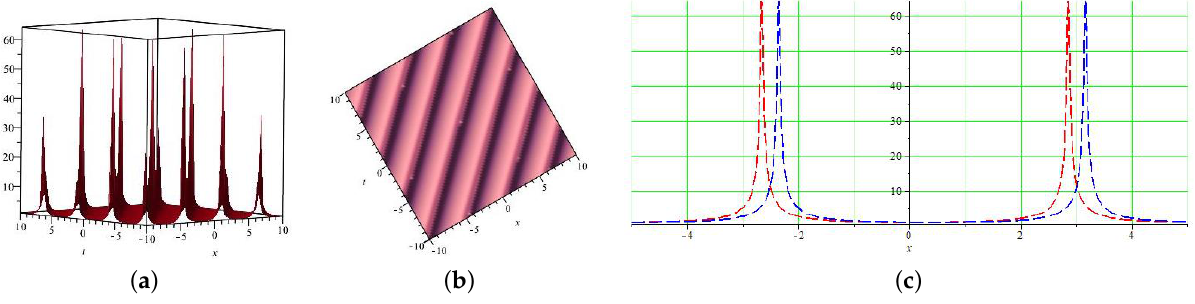
Figure 1. Graph of Z 1 . ( a ) 3D plot. ( b ) Contour plot. ( c ) 2D plot.